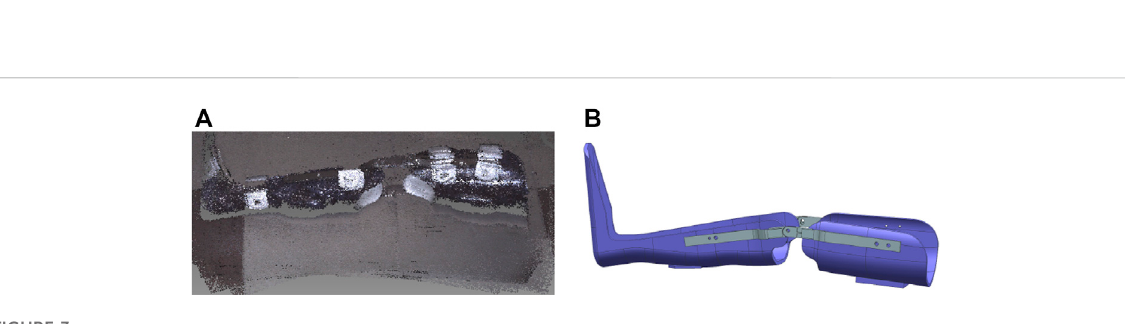
Orthosis production: (A) — formation of a plaster cast of the leg of the subject, (B) — a groove for fastening, (C) — a ready orthosis with marked sites for fastening.